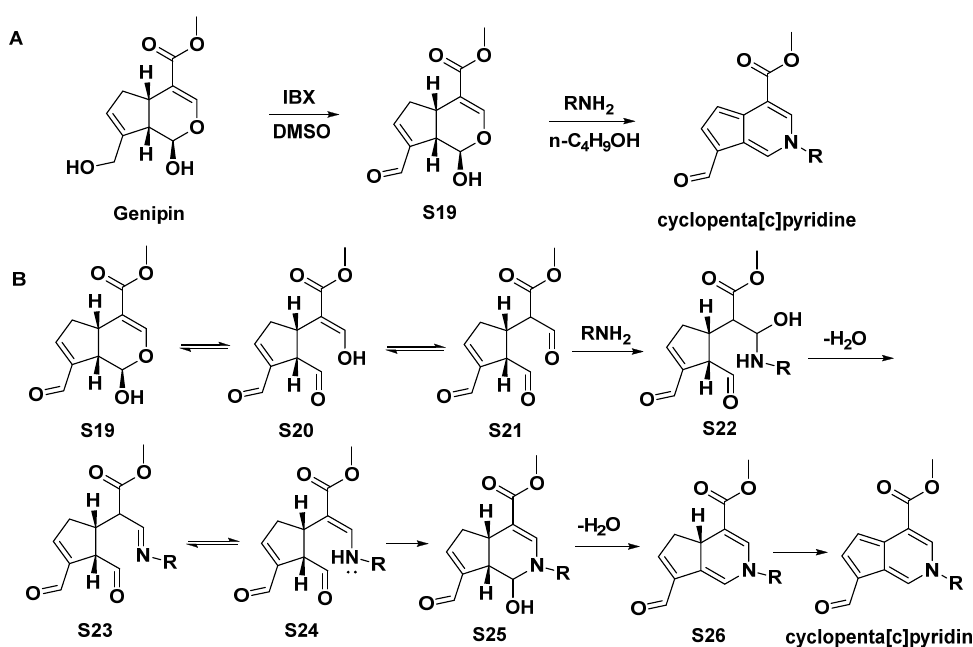
Figure 8. Cyclopenta[c]pyridine products ( 91–112 ) obtained from a concise biomimic access.